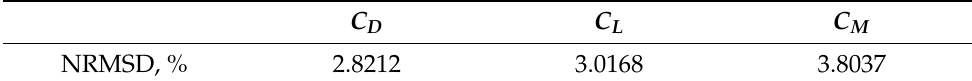
Table 5. Error analysis of surrogate model for Waid-Lindberg supercavitating hydrofoil.